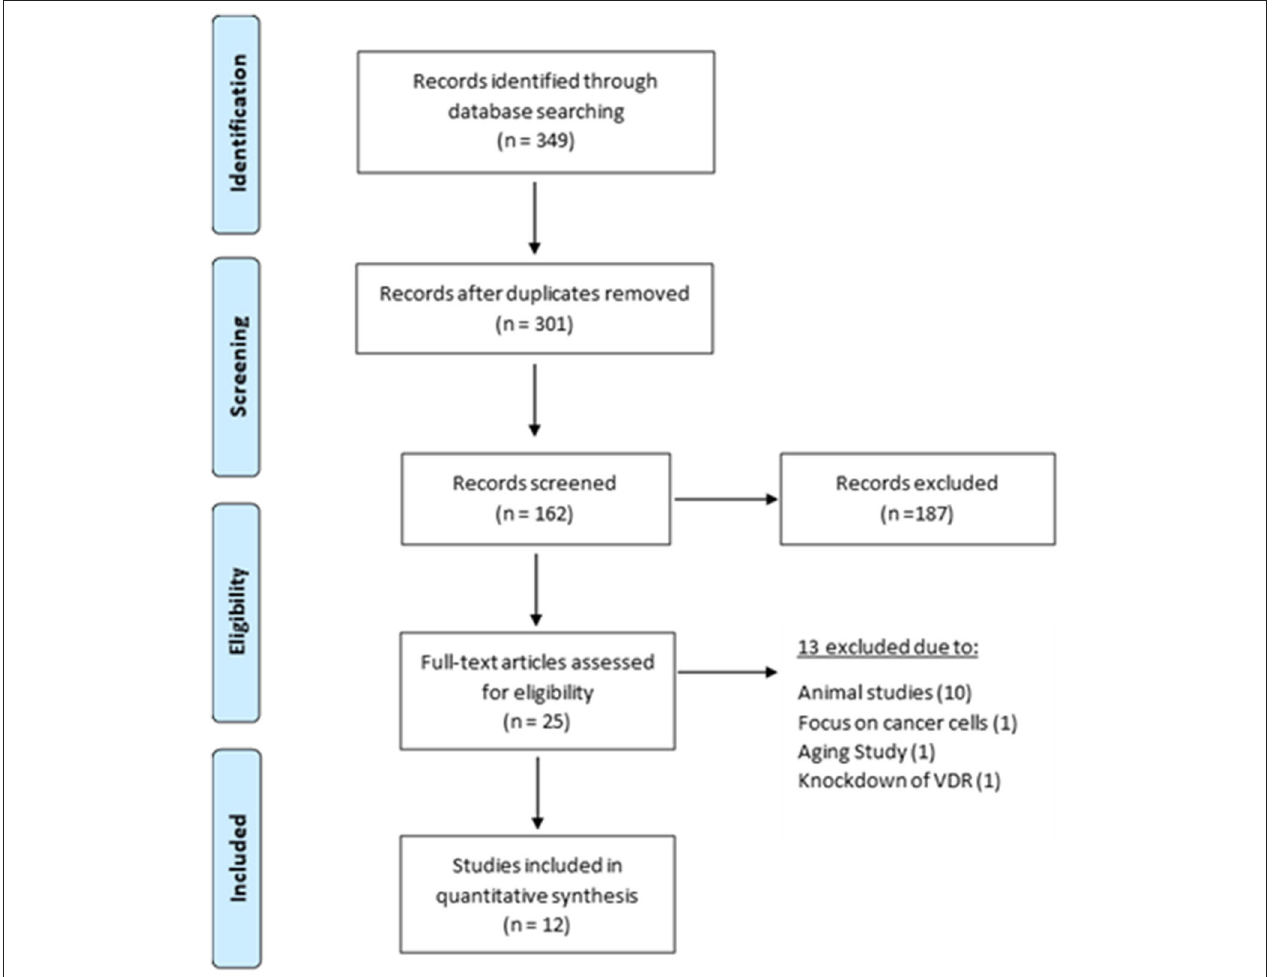
FIGURE 2 | Selection and exclusion of studies in accordance with PRISMA guidelines (Moher et al., 2009). day 4 (0.7-fold). The remaining three studies (Olsson et al.,